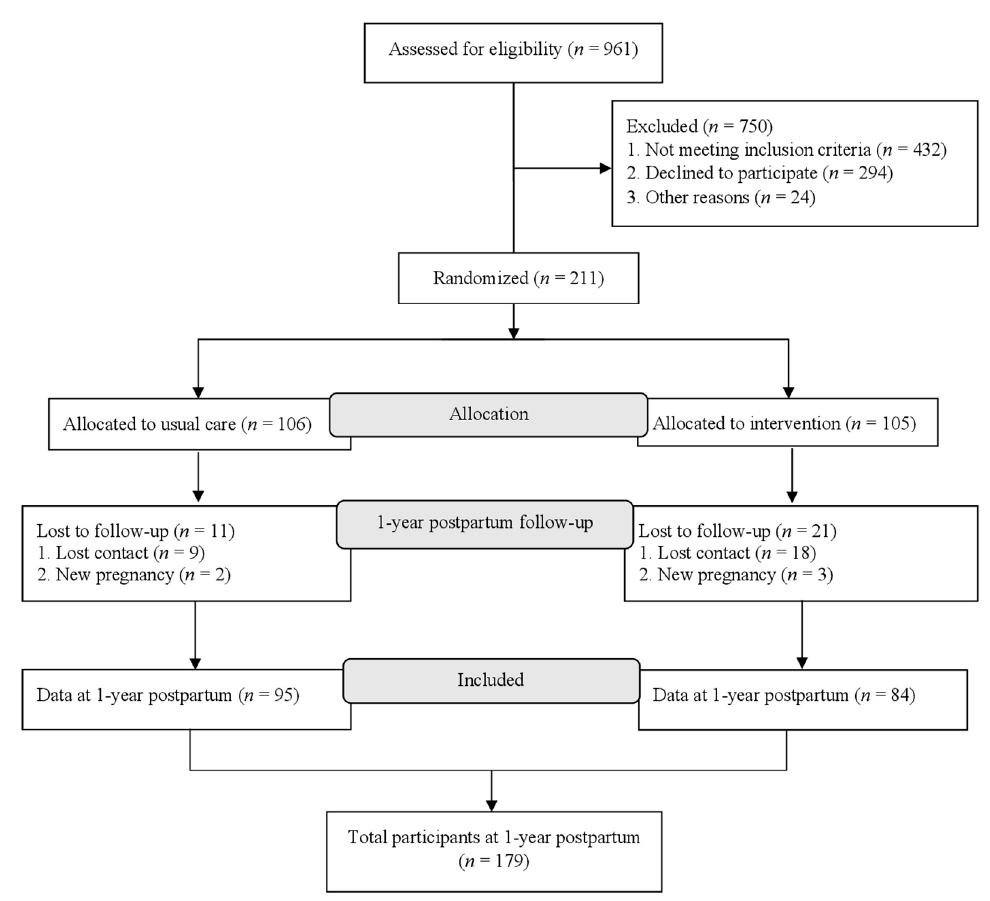
Figure 1. Flow of study participants. Of the 211 women included at baseline, 179 completed the 1-year follow-up and were included in this analysis. Out of these 179 women with data at 1-year postpartum visit, 100 had valid dietary data and 162 had valid data for HOMA-IR.